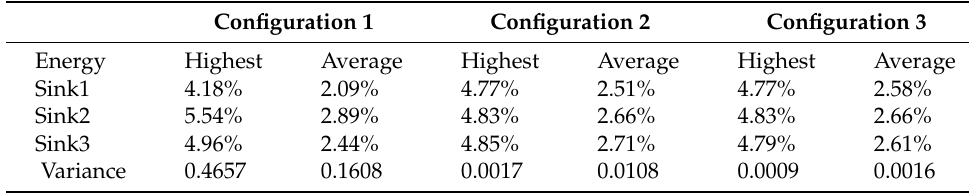
Table 4. Node migration: Energy consumption.